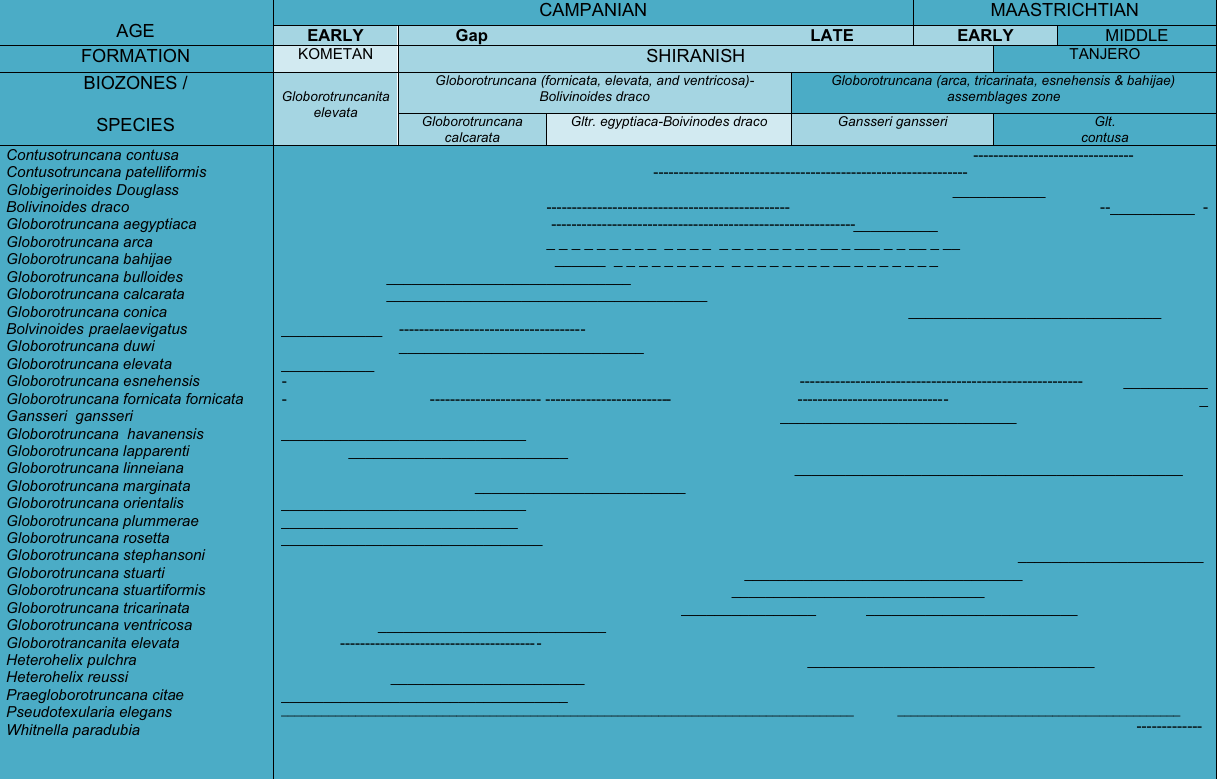
Table 2 Generalized distribution chart of the planktonic foraminifera in Shiranish and lower part of Tanjero